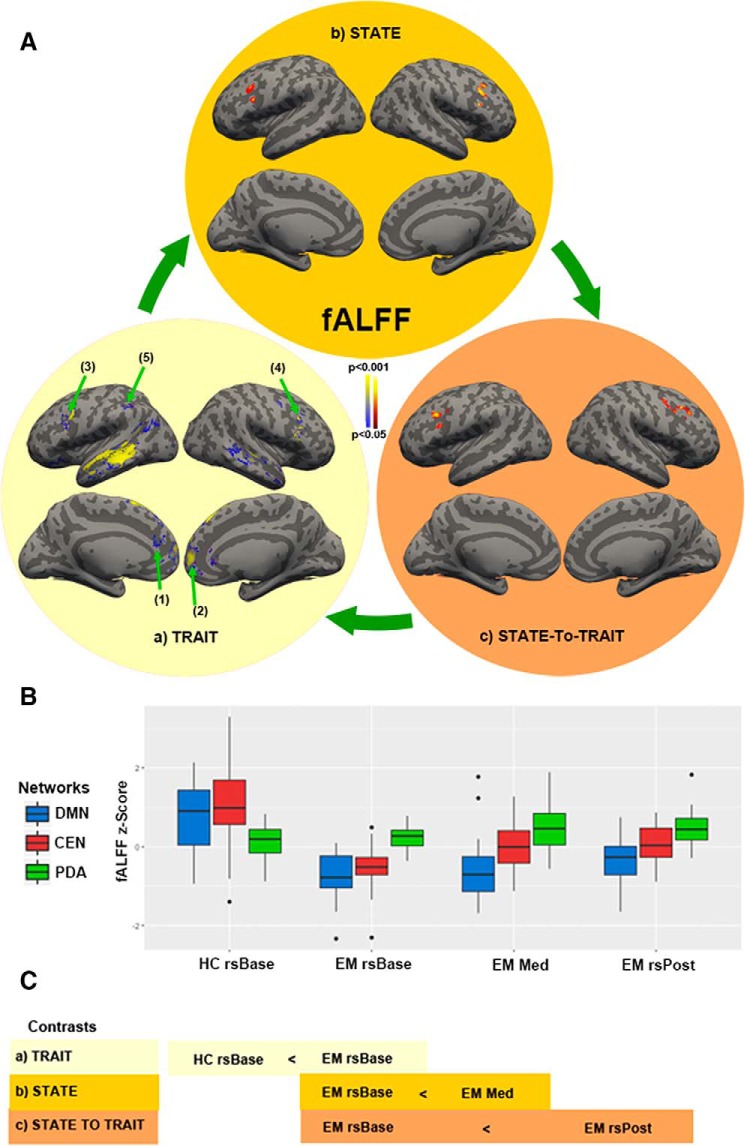

State-to-trait meditation brain activity changes of the fractional Amplitude of Low-Frequency Fluctuations (fALFFs). Aa, Brain regions showing trait changes in fALFF between meditators and HCs at baseline (HC rsBase < EM rsBase). Ab, Brain regions that show significant changes in fALFF during the meditation state in meditators (EM rsBase < EM Med). Ac, Brain regions that show significant changes in fALFF during the transition from state-to-trait meditation in meditators (EM rsBase < EM rsPost). B, Boxplot showing the mean fALFF z-scores in blue (DMN) and red (CEN) and PDA scores in green during baseline (rsBase), meditation (Med) and post-meditation (rsPost) for HCs and EMs. C, Schematic representation of state-to-trait contrasts. All stats shown are nonparametric (5000 permutations) with height threshold p < 0.05 and cluster-size FDR-corrected p < 0.05. Black dots represent subjects that lie beyond the whiskers.